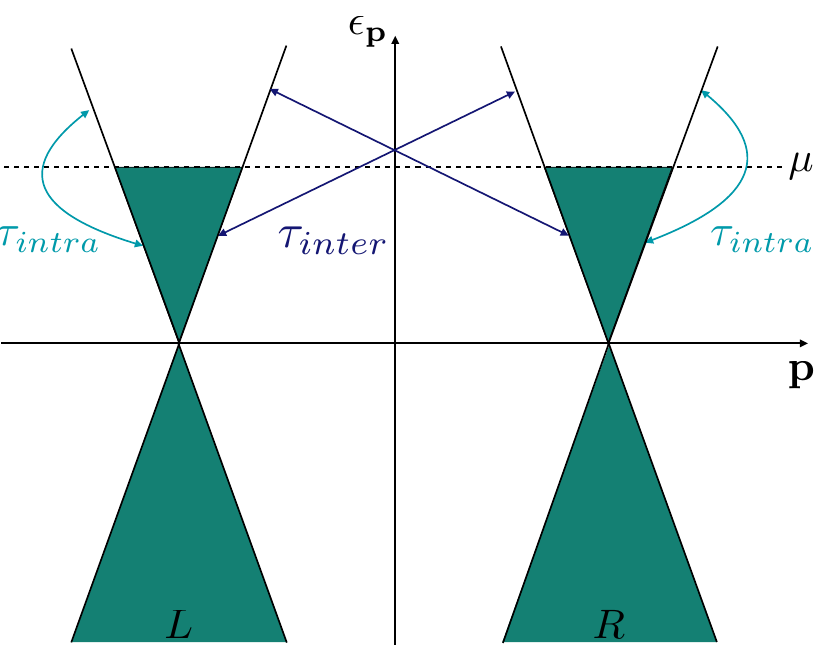
Figure 2 . A schematic representation of two scattering processes in a simple Weyl metal, pos- sessing linear dispersion along all three direction. Respectively the forward (intravalley) and back (intervalley) scattering processes are shown by turquoise and blue arrows. The chemical potential ( (cid:22) ) is measured from the band touching point. This construction is also applicable for arbitrary monopole charge n . Here L and R respectively denotes the Weyl node with left and right